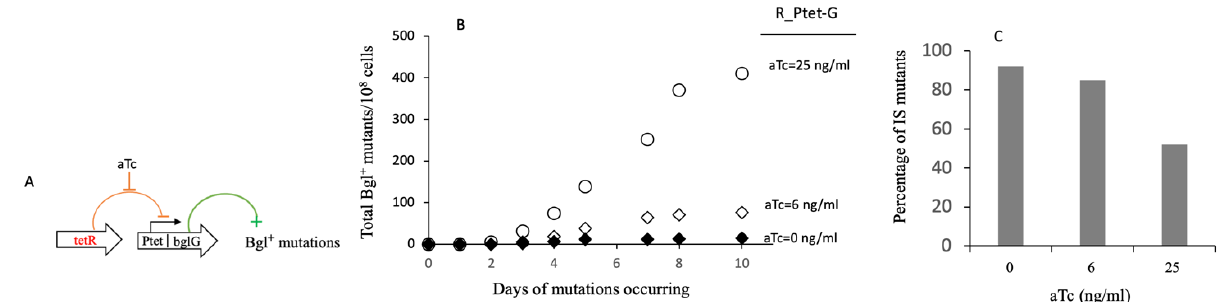
Figure 2. Dependence of total Bgl + mutations and IS insertional Bgl + mutations on BglG levels. A total of 2 × 10 7 cells of strain R_Ptet-G were applied on M9 + salicin agar plates with various levels of aTc (the inducer for TetR-repressed P tet ). The Bgl + mutations were carried out as for Figure 1. ( A ) Diagram showing TetR inhibition of bglG expression and BglG activation of Bgl + mutations. As an inducer, aTc releases TetR from the P tet promoter, thereby allowing bglG expression. The more aTc added, the greater the expression of bglG . In the absence of an inducer (aTc), no additional BglG (BglG production is only from the native bgl operon) is produced. ( B ) Effects of titrated bglG expression on total Bgl + mutations. ( C ) Effects of BglG levels on the ratios of IS insertional mutants out of the total number of Bgl + mutants.